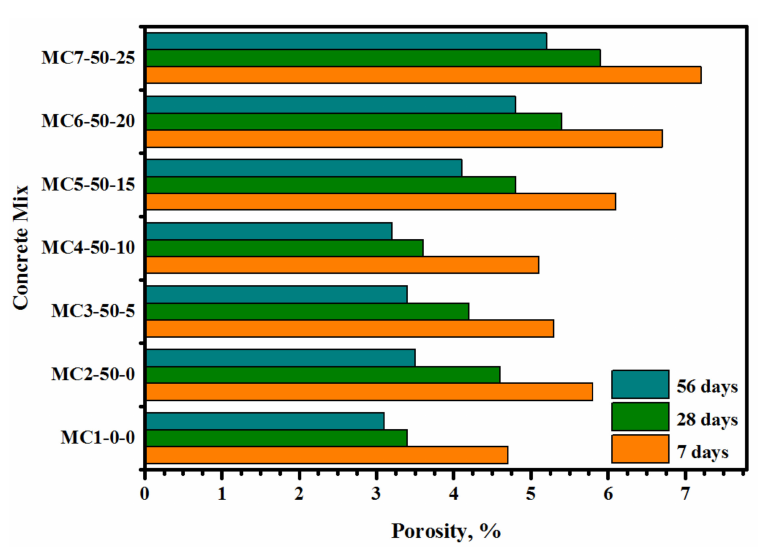
Figure 7. FA/EM contents-dependent porosity variation of the bio-concrete